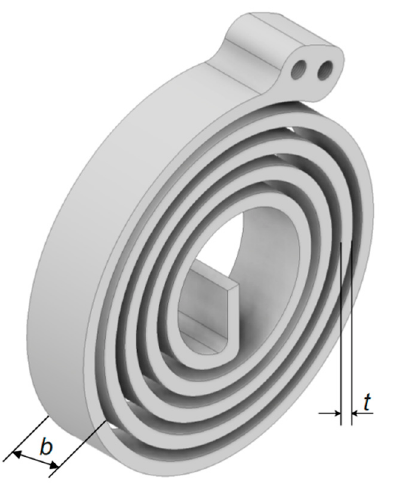
Figure 10. CAD for designed spiral spring .